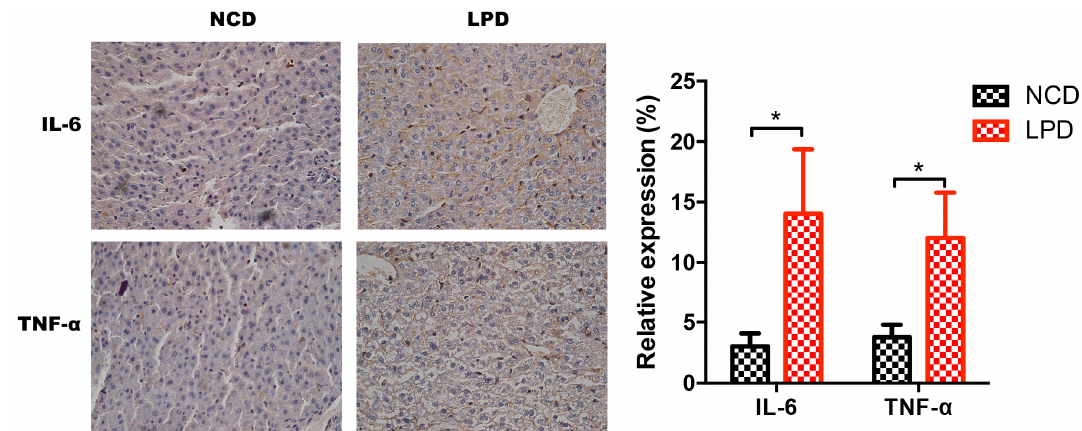
Figure 6. Immunohistochemistry for IL ‐ 6 and TNF ‐α expression and semi ‐ quantitative assessments. ( left ) IL ‐ 6 and TNF ‐α staining in NCD and LPD groups. ( right ) Semi ‐ quantitative scores of IL ‐ 6 and TNF ‐α . Data represented as the mean ± SEM ( n = 6 to 8, per group). * p < 0.05, vs. the NCD group. LPD, low ‐ protein diet; NCD, normal chow diet; IL ‐ 6: interleukin ‐ 6; TNF ‐α : tumor necrosis factor ‐α .